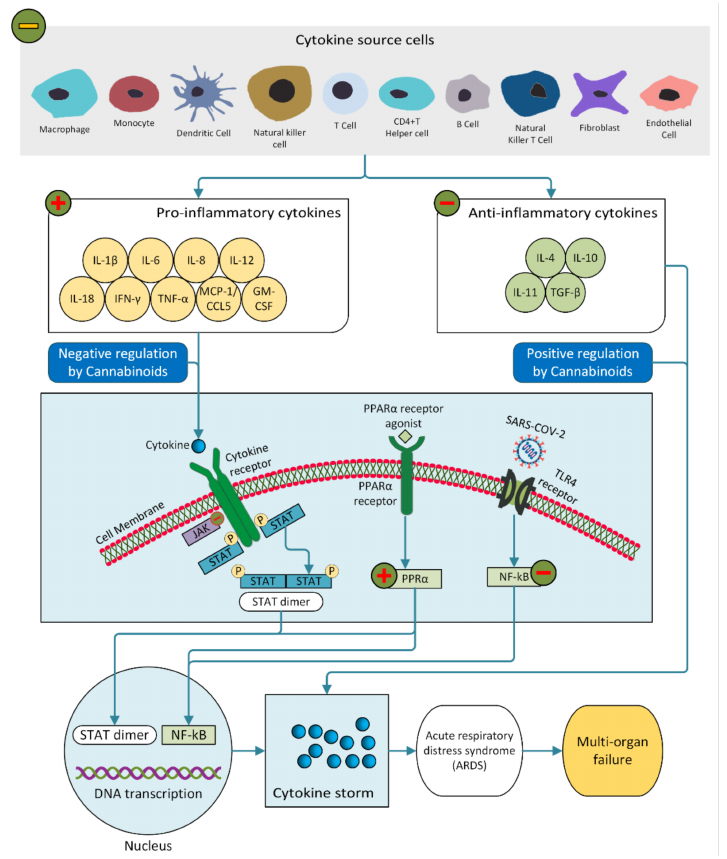
Figure 3. The impact of the cannabinoid system on the immune system in SARS-CoV-2 infection (adapted from